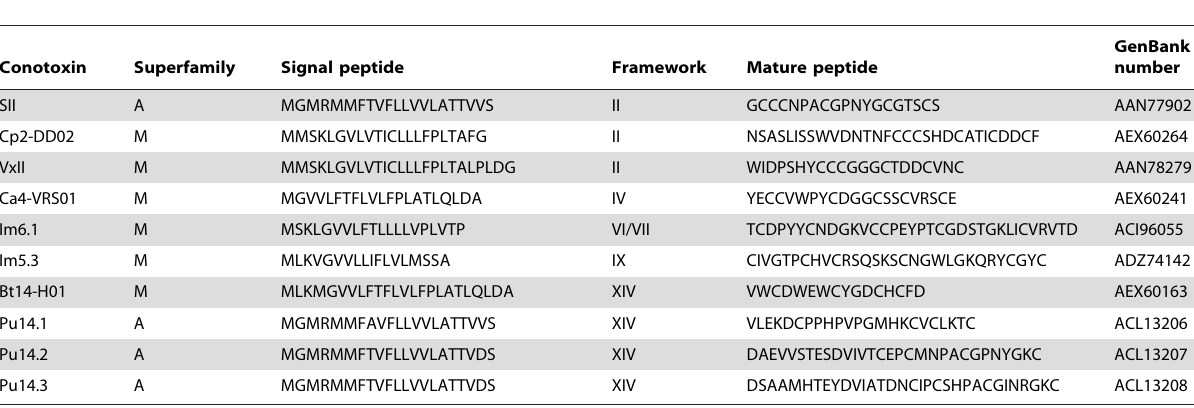
Table 4. Conotoxins that may be involved in gene recombination